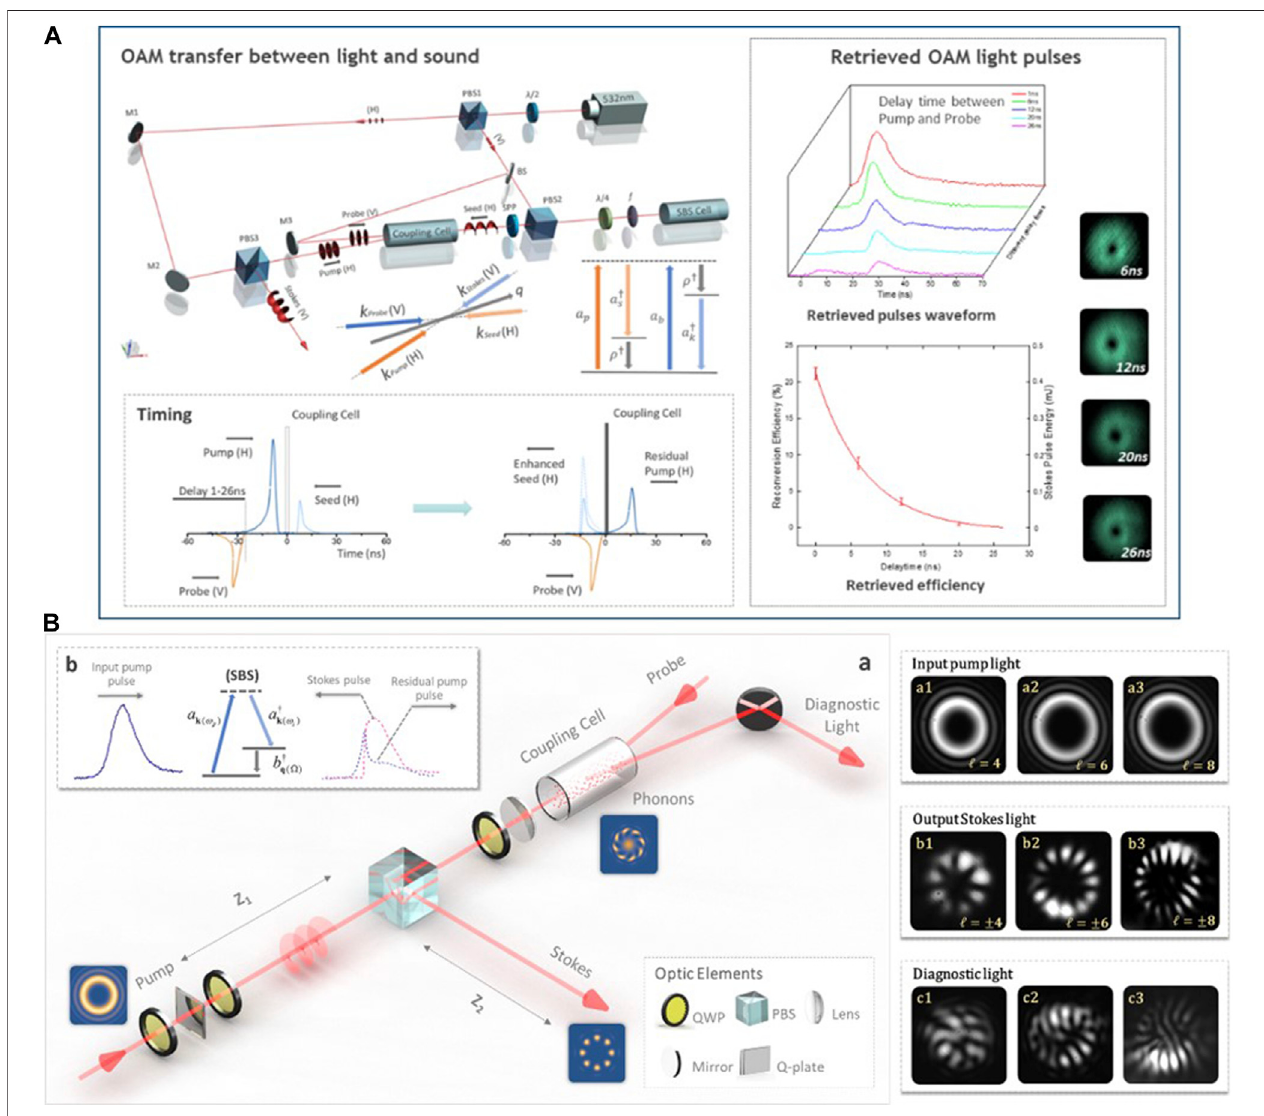
FIGURE11| RealizationofOAMinterconversionbetweenlightandsoundwavesviaSBS (A) anddemonstrationoffragmentationofvortexbeamsinanSBS-PCM (B) [28, 39].